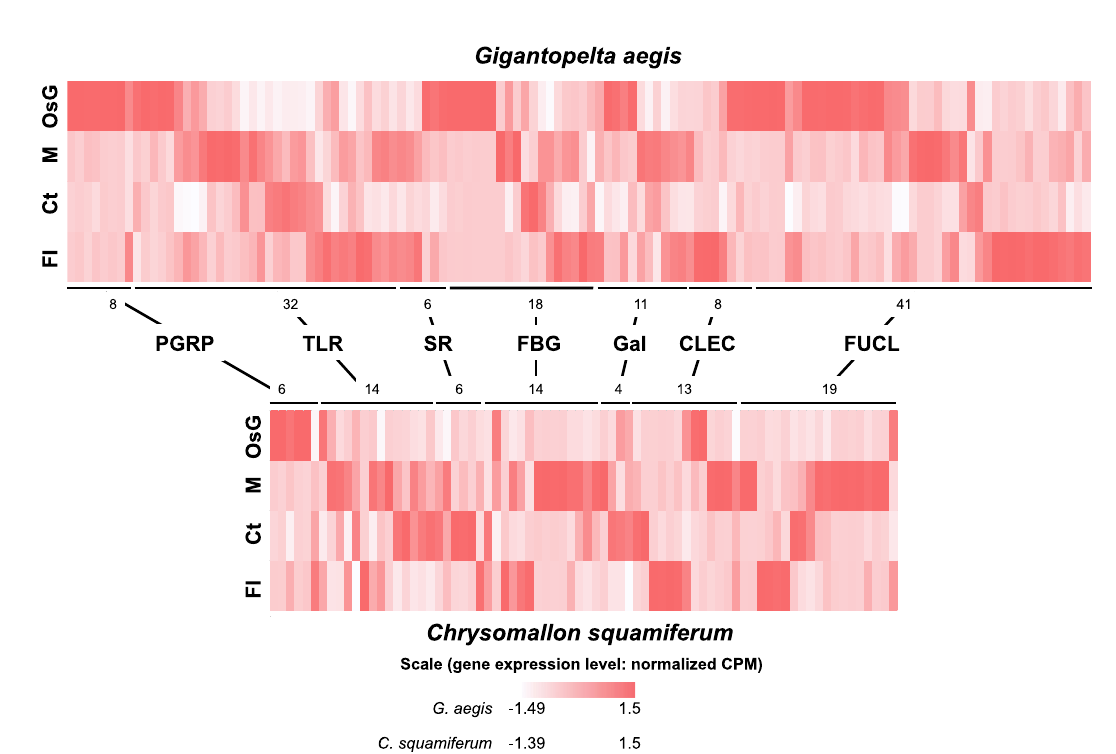
Fig. 7 Heat maps showing gene abundances and expression levels of pattern recognition receptors in Gigantopelta aegis and Chrysomallon squamiferum . Two heat maps showing gene abundances and expression levels of pattern recognition receptors, including peptidoglycan recognition protein (PGRP), toll-like receptor (TLR), scavenger receptor (SR), fi brinogen-related protein (FBG), galectin (Gal), C-type lectin (CLEC), and fucolectin (FUCL), in Gigantopelta aegis ( n = 4) and Chrysomallon squamiferum ( n = 3) 17 (OsG: oesophageal gland; M: mantle; Ct: ctenidium; FI: internal tissue of foot). The numbers near the lines indicate the gene numbers of the gene families. The colour represents the gene expression level (normalised CPM value). Red: high expression level. Light: low expression level; n means biologically independent animals. Source data are provided in a Source Data fi